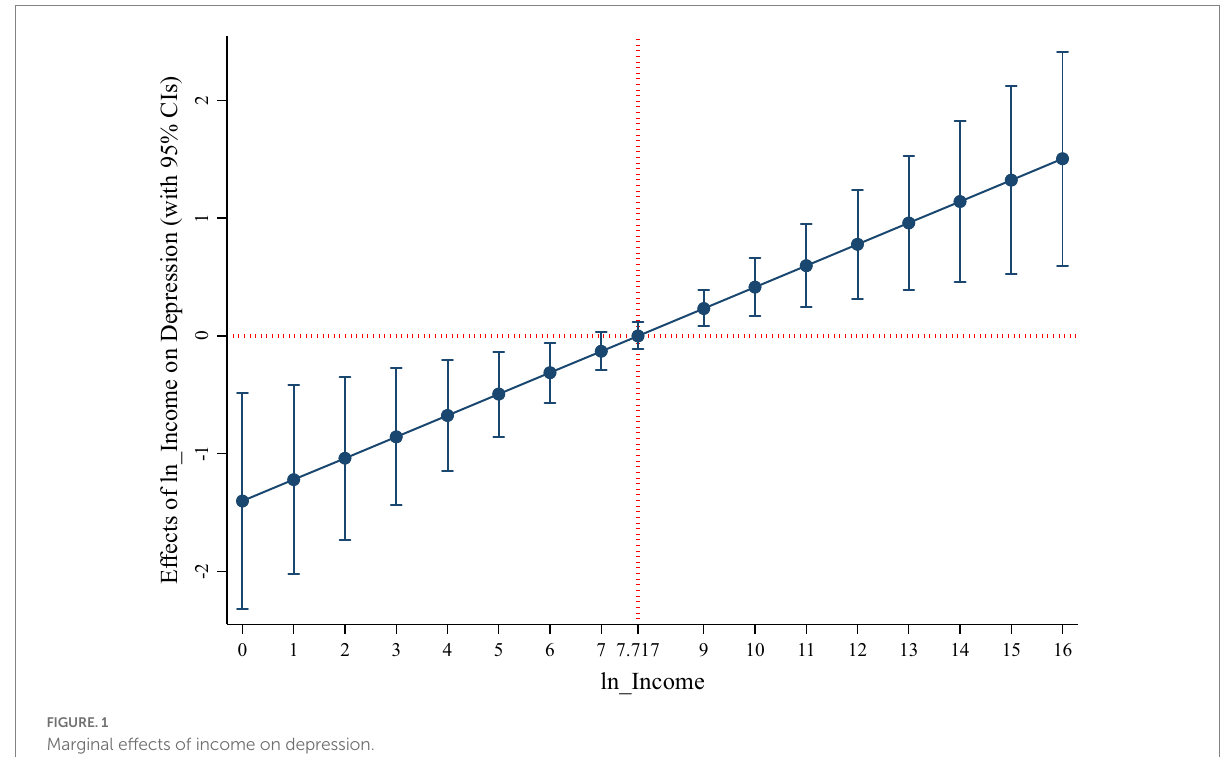
FIGURE. 1 Marginal effects of income on